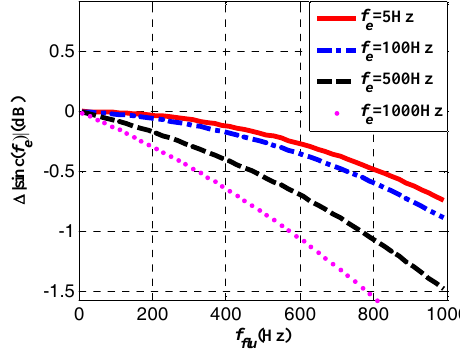
Figure 7. Attenuation caused by fluctuation at different static frequency errors.